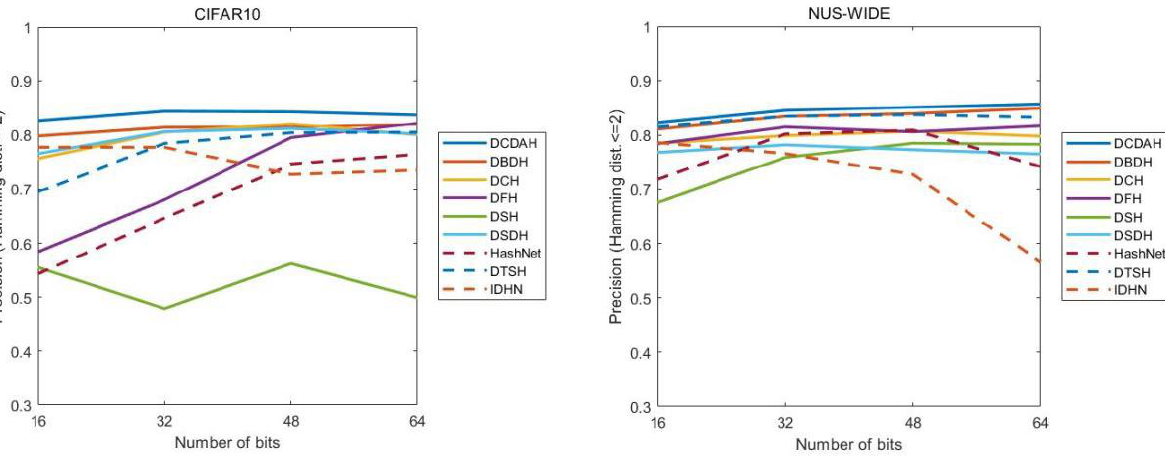
Figure 6. PR curves of all algorithms on NUS-WIDE when the hash code takes 4 different lengths.